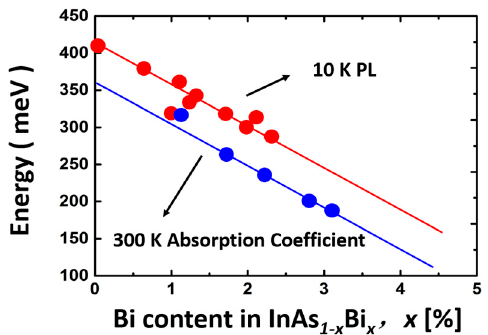
Figure 13. Photoluminescence peak energy and absorption edge vs Bi composition at 10 and 300 K, respectively. The slopes are close to 55 meV/% Bi for both results. Reproduced from [168] [Photoluminescence of InAsBi and InAsSbBi grown by organometallic vapor phase epitaxy], with the permission of AIP publishing.